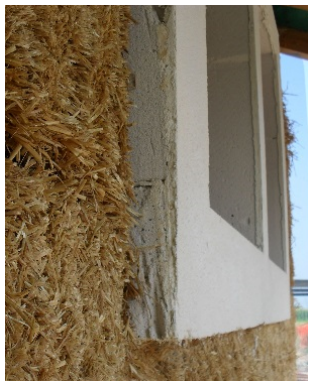
Figure 9. Edging of the windows with calcium silicate panels.